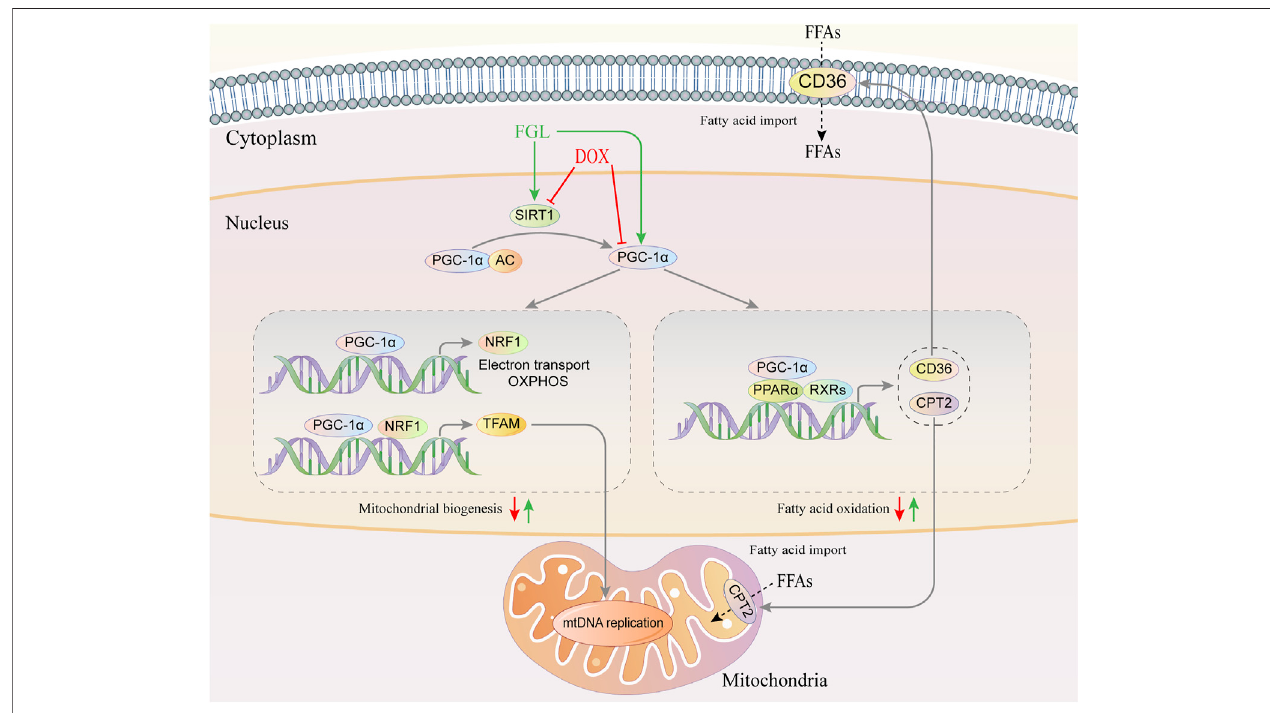
Frontiers in Pharmacology |